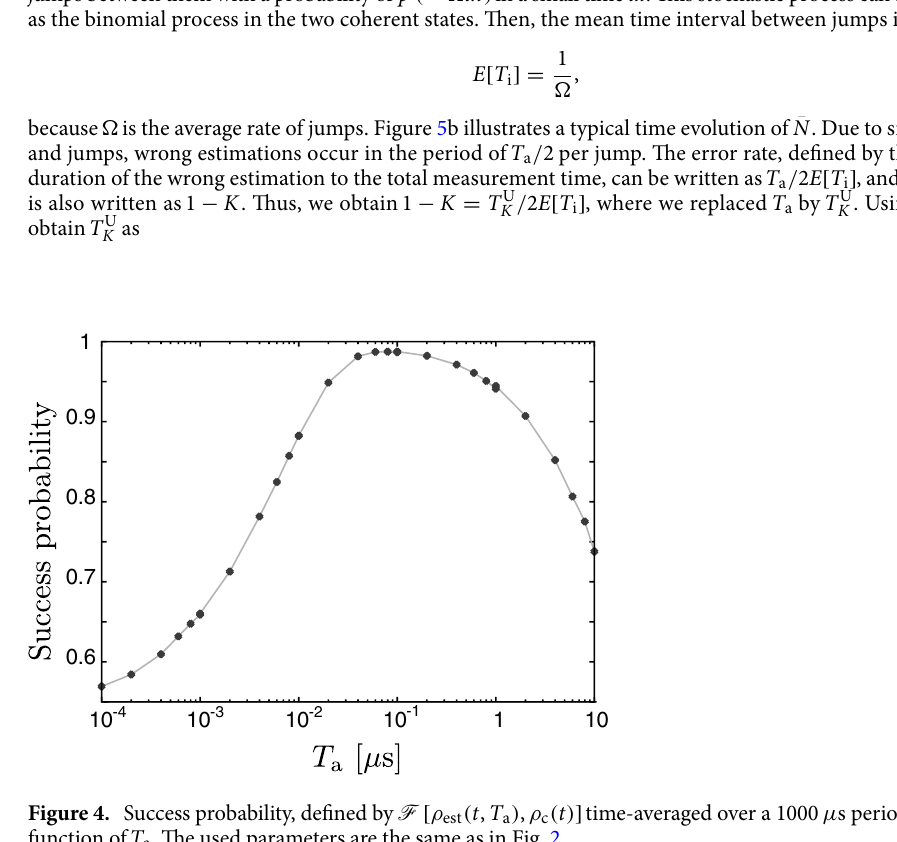
Figure 4. Success probability, defined by F function of T a . The used parameters are the same as in Fig.